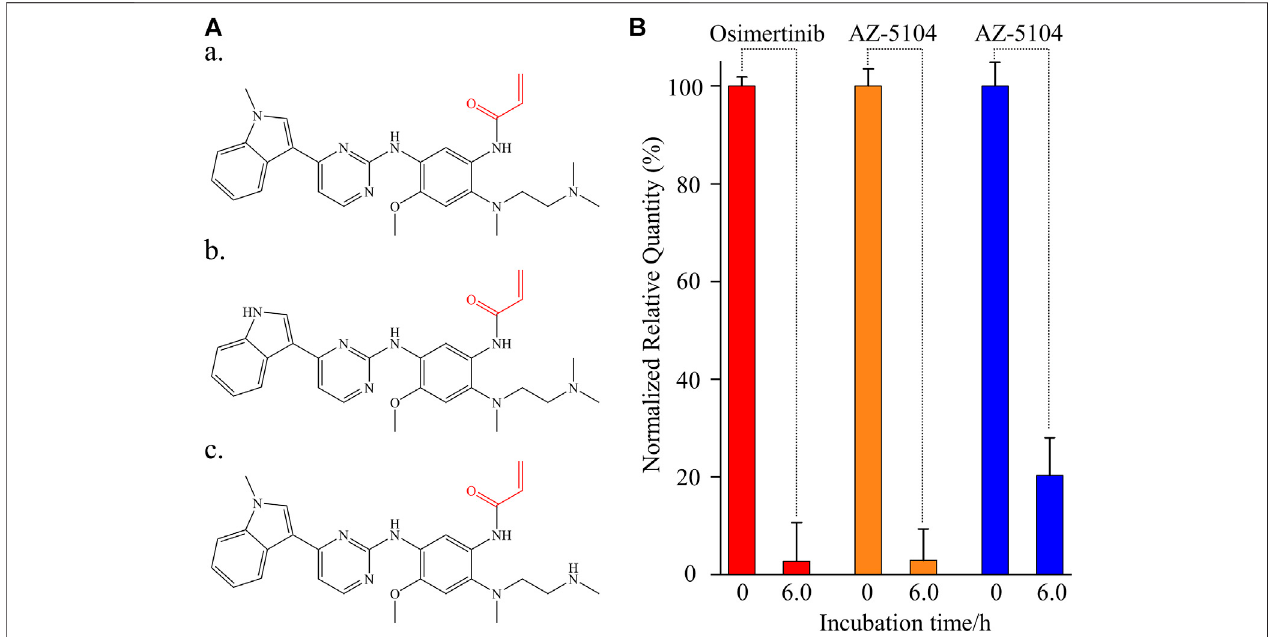
FIGURE 1 | Instability of osimertinib, AZ-5104, and AZ-7550 in rat plasma. (A) Chemical structure of (a) osimertinib, (b) AZ-5104, and (c) AZ-7550. The Michael acceptor functional groups are labelled red. (B) Histogram of the normalized relative quantity of osimertinib (red), AZ-5104 (orange), and AZ-7550 (blue) after the incubation in rat plasma at 39 ° C for 0 and 6 h. The concentrations of analytes including propranolol in rat plasma were 10 ng/ml. The normalized relative quantity (NRQ) was calculated as the analyte/propranolol area ratio corresponding to the proposed incubation time of 0 h or 6 h over the area ratio for 0 h ( n = 6). If not speci fi ed, the conditions listed upon adapted to the follow-up